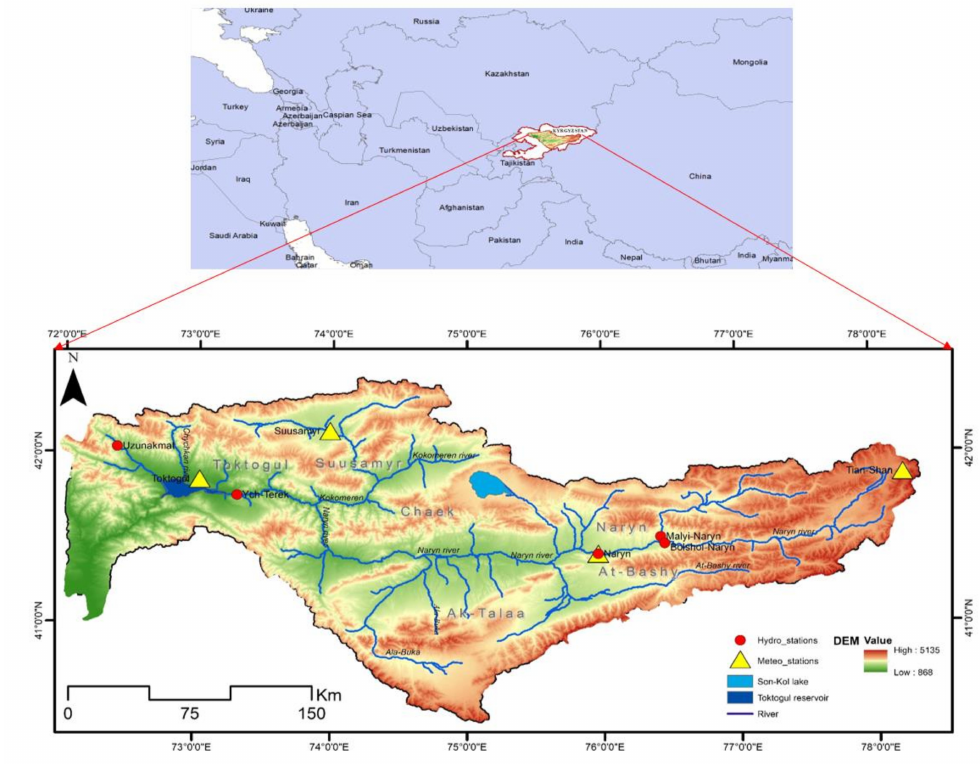
Figure 1. The map of the Naryn river